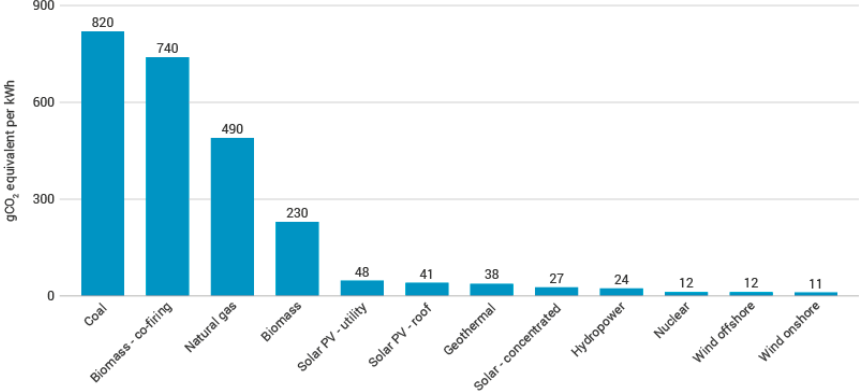
Figure 4. Representative scheme of allowances at auction.